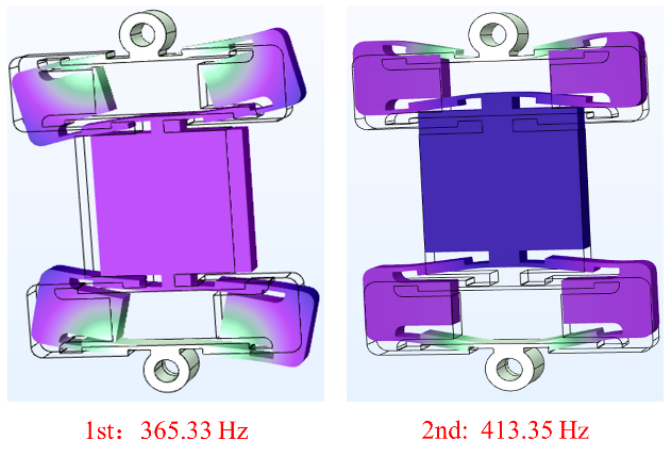
Figure 7. Characteristic frequency of the series bridge mechanism.